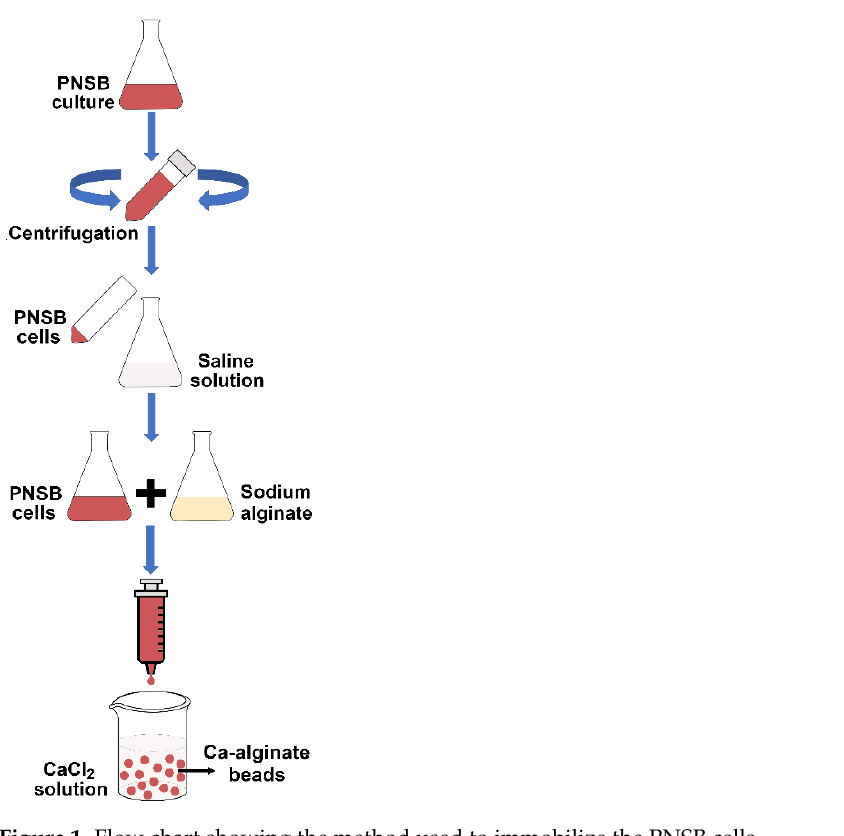
Figure 1. Flow chart showing the method used to immobilize the PNSB